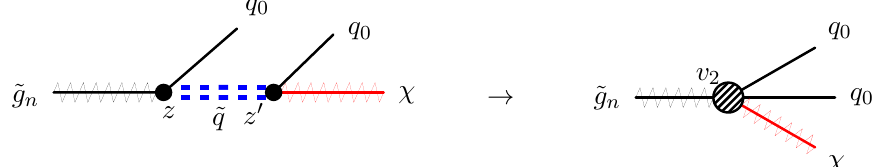
(cid:22) q 0 ~ (cid:31) 0 e(cid:11)ective vertex (right) from the propagation of squark in 5D L L